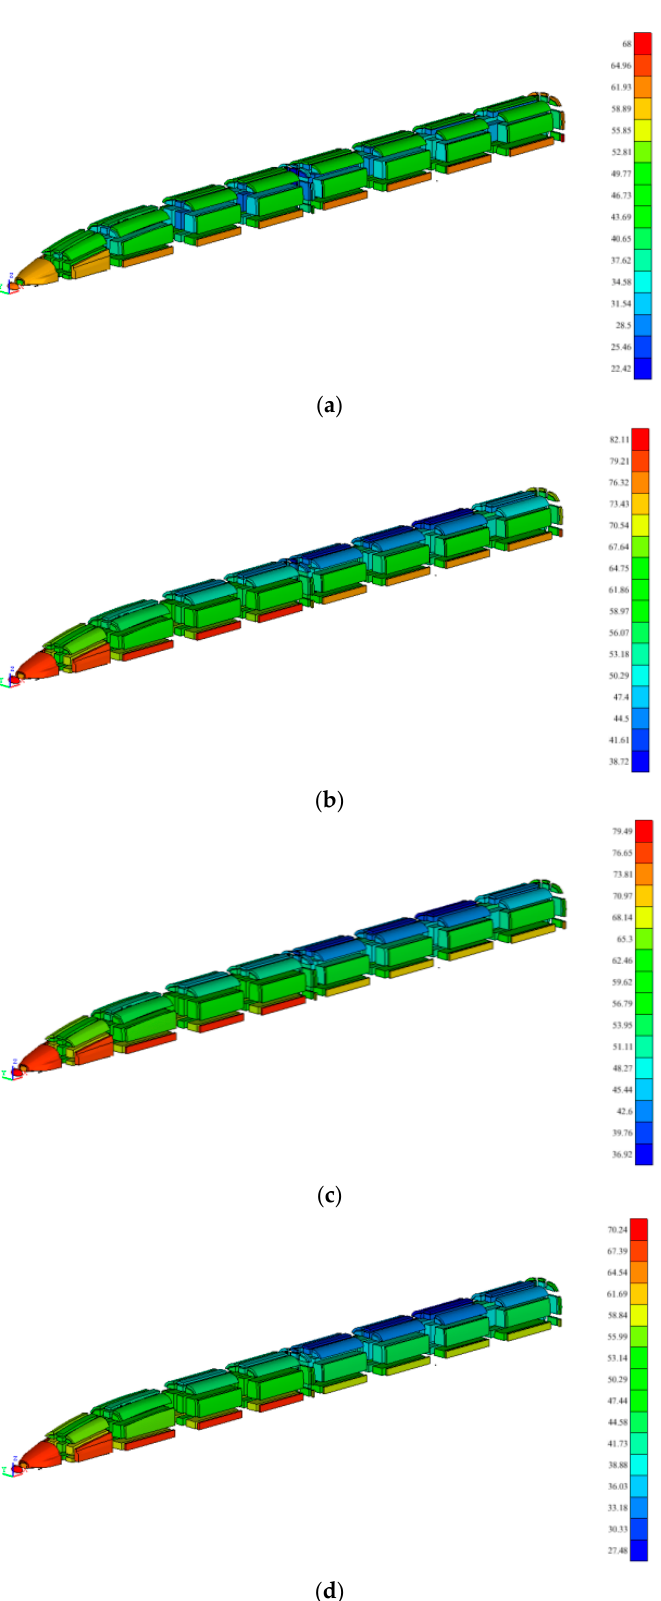
Figure 8. Interior aerodynamic noise of head and middle cars: ( a ) 100 Hz, ( b ) 500 Hz, ( c ) 1000